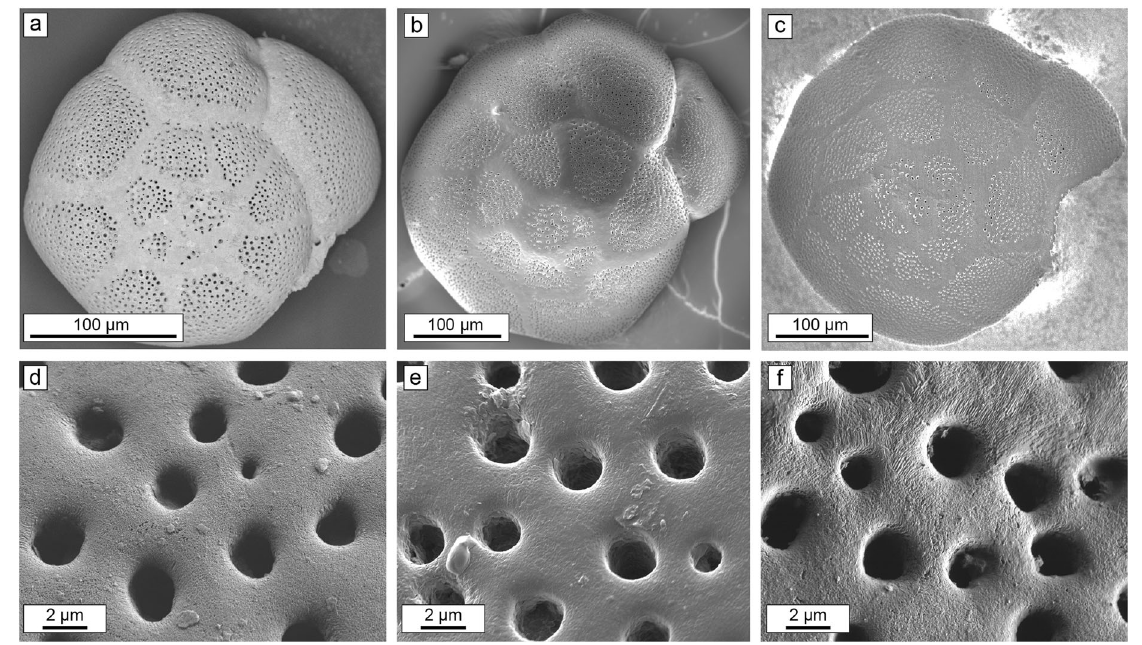
Fig. 1 Scanning electron microscope (SEM) images of foraminifera test morphology and respective surface textures prior to and after isotopic exchange experiments. a Visually pristine methanol-cleaned foraminifera test prior to incubation. b Image of foraminifera test incubated in arti fi cial seawater (ASW) at 90 °C for 54 days with an 18 O-enrichment at 1000 ‰ VSMOW. c Foraminifera test incubated in Na 2 CO 3 buffered Milli-Q at 190 °C for 40 days with a 18 O-enrichment at 1000 ‰ VSMOW. d – f Corresponding high-resolution SEM images of panels a – c , respectively. Note the absence of any visible textural changes in b and c compared with the pristine un-reacted foraminifera test of image a . An extensive set of comparison images between incubated and pristine foraminifera made under the same experimental parameters can be found in the supplementary information of Cisneros-Lazaro et al. 12 .